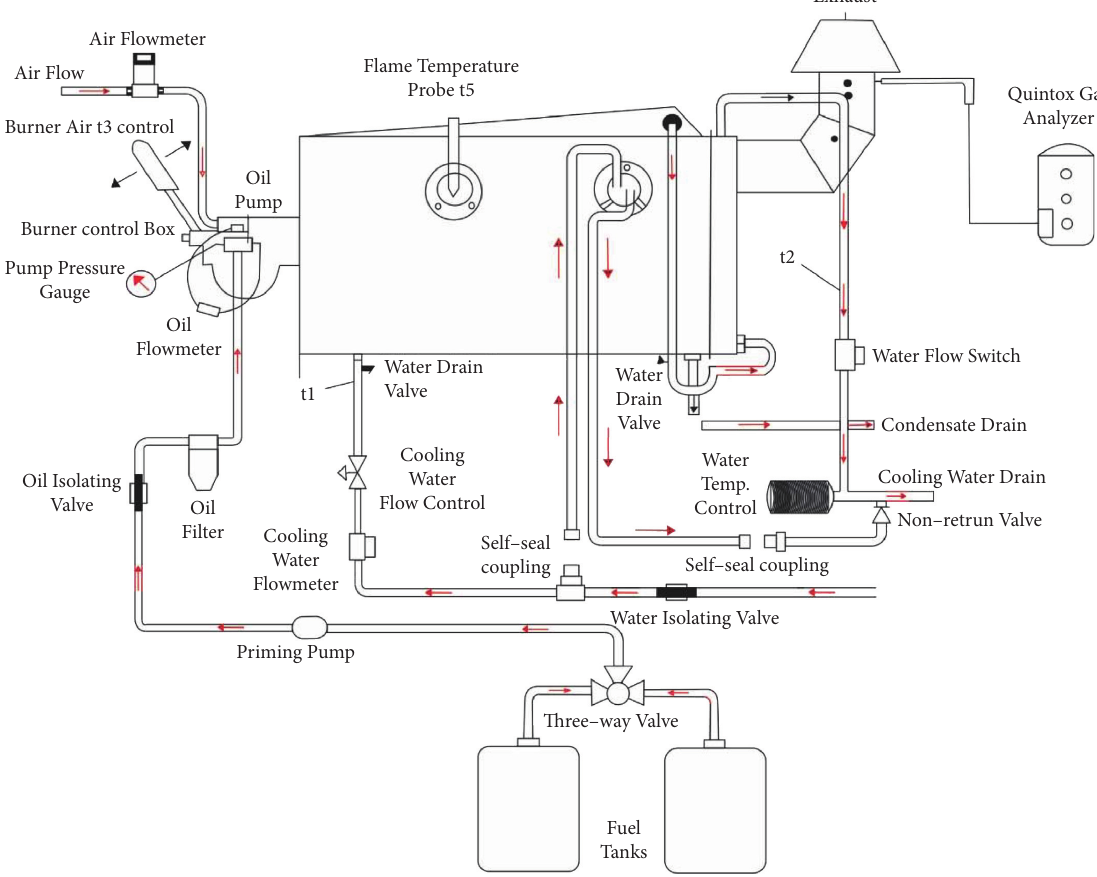
Figure 3: Boiler scheme